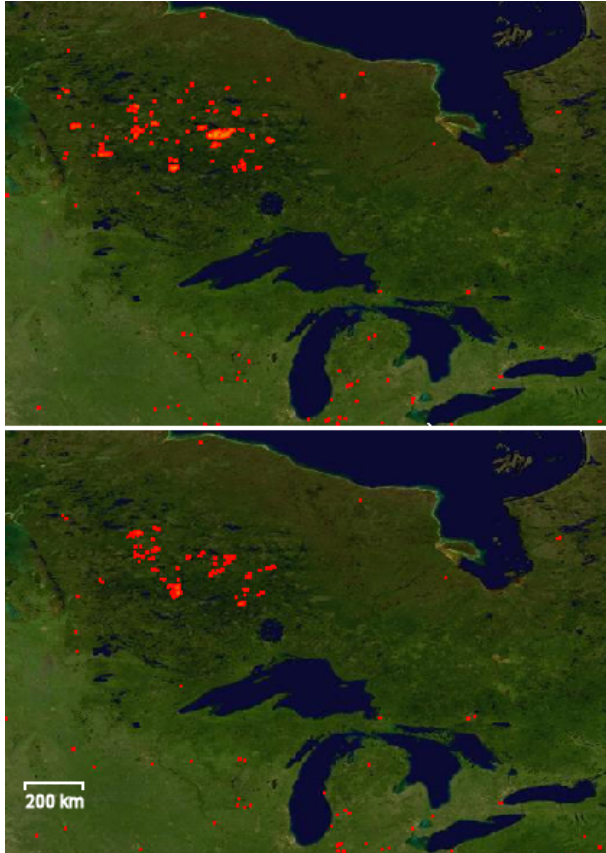
Figure 2. MODIS fire maps showing the reduction in fire activity in north-western Ontario between the 10 day periods of 10–19 July 2011 (top) and 20–29 July 2011